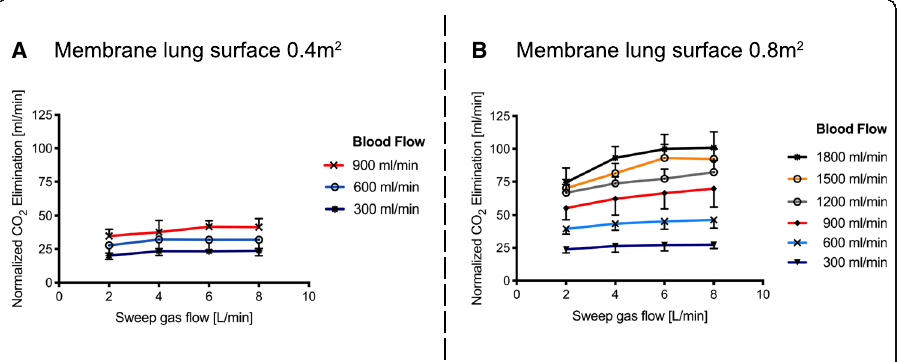
Fig. 1 Normalized extracorporeal elimination of carbon dioxide (CO 2 ) depending on blood flow and sweep gas flow with a membrane lung surface of 0.4m 2 ( a ) and 0.8m 2 ( b ). Normalized CO 2 elimination was calculated by normalizing the partial pressure of carbon dioxide before the membrane lung to 45 mmHg. The normalized extracorporeal CO 2 elimination was plotted against sweep gas flow. Blood flow was titrated from 300 to 900 mL/min ( a ) and 300 to 1800 mL/min ( b ). Each data point represents the mean and standard deviation among nine